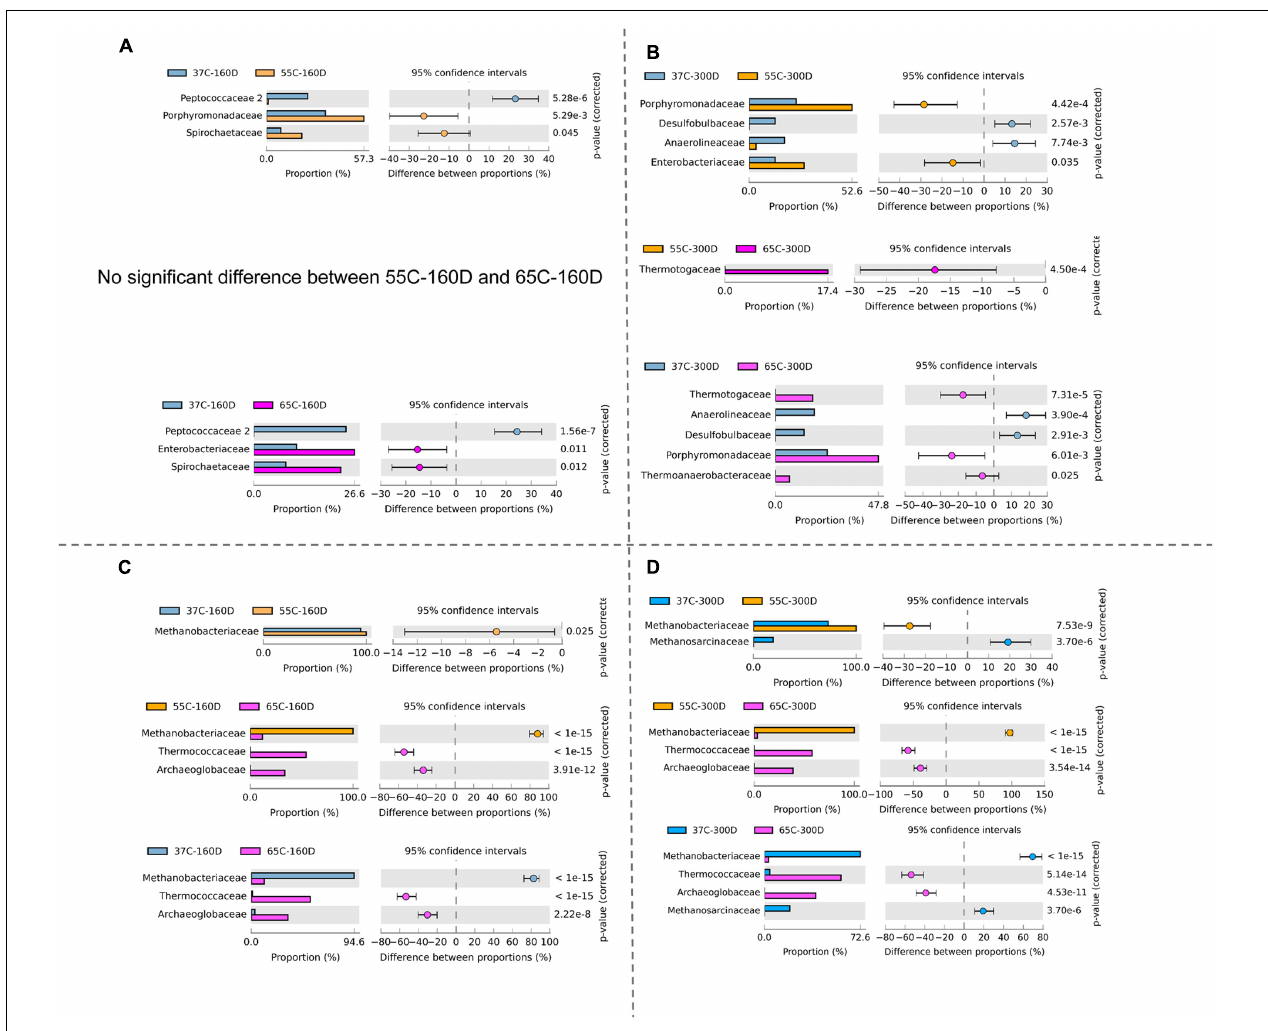
FIGURE 7 | Bacterial (A,B) and archaeal (C,D) communities differences at the family level as revealed by the extended error bar method in STAMP using the two-sided Fisher’s exact